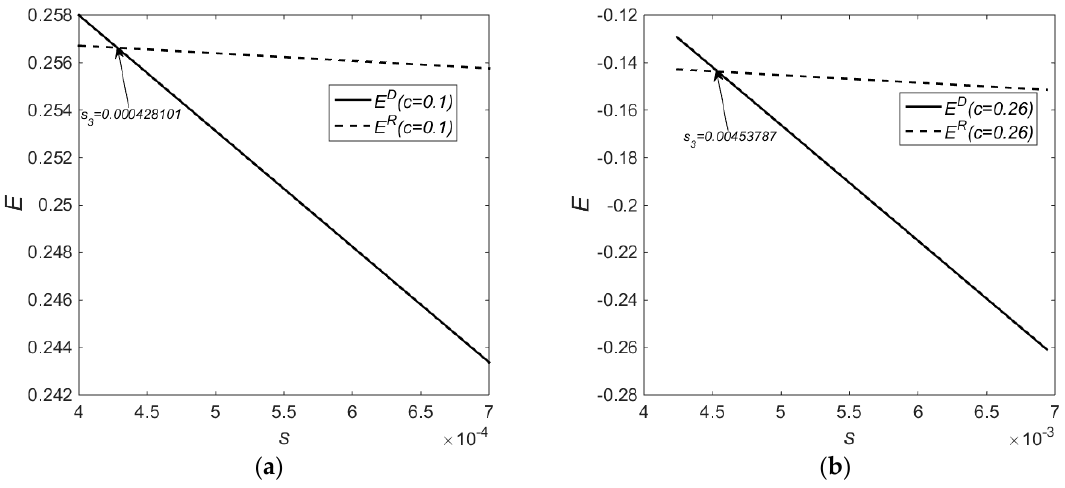
Figure 3. Impact on Environmental Benefits by Different Subsidy Levels; ( a ) =0.1 c , ( b ) 0.26 c = .